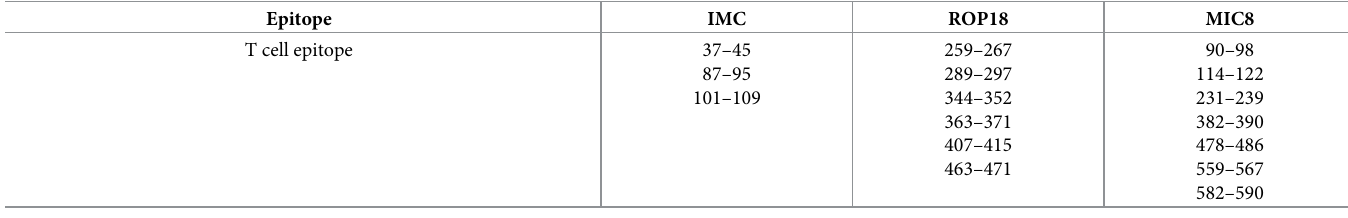
Table 1. The T cell and B cell epitopes predicted in protein IMC, ROP18 and MIC8. Epitope IMC ROP18 MIC8 T cell